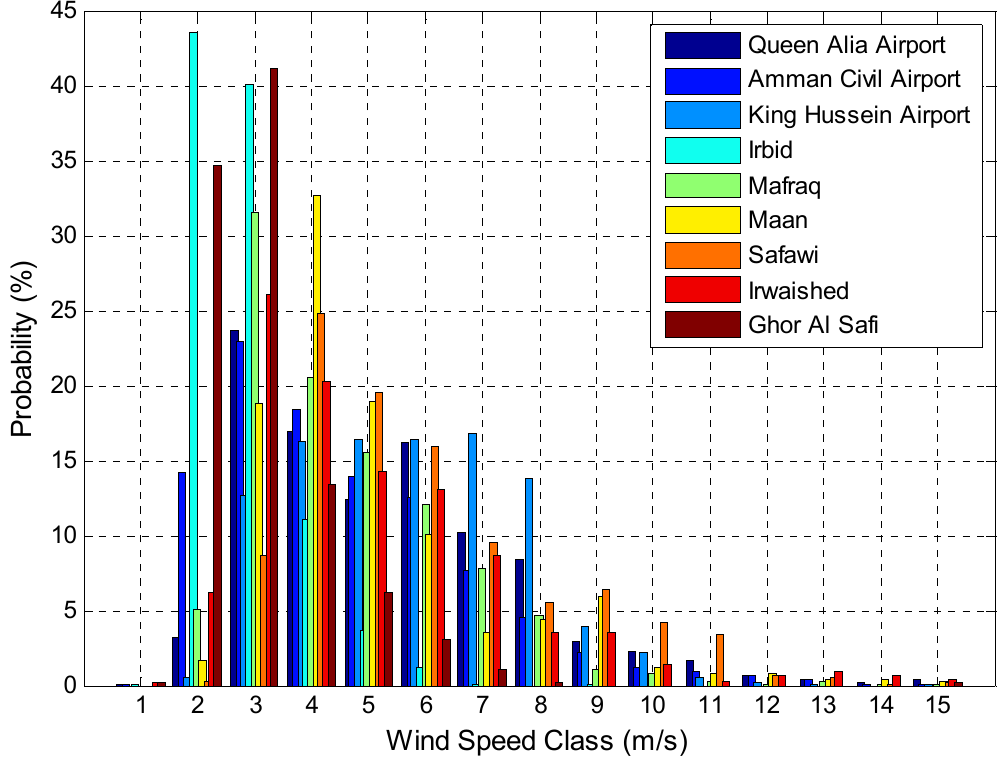
Figure 1. Probability of wind speed distribution for all sites.